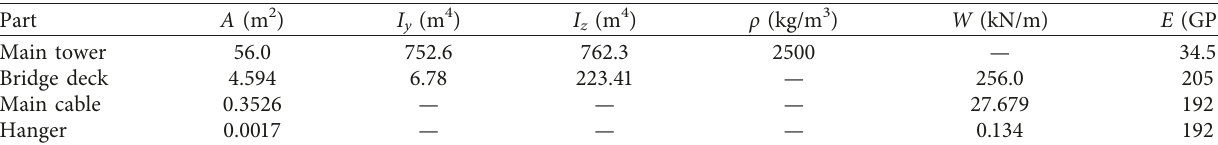
Figure 3: The FE model of the suspension bridge. Table 1: Parameters of the suspension